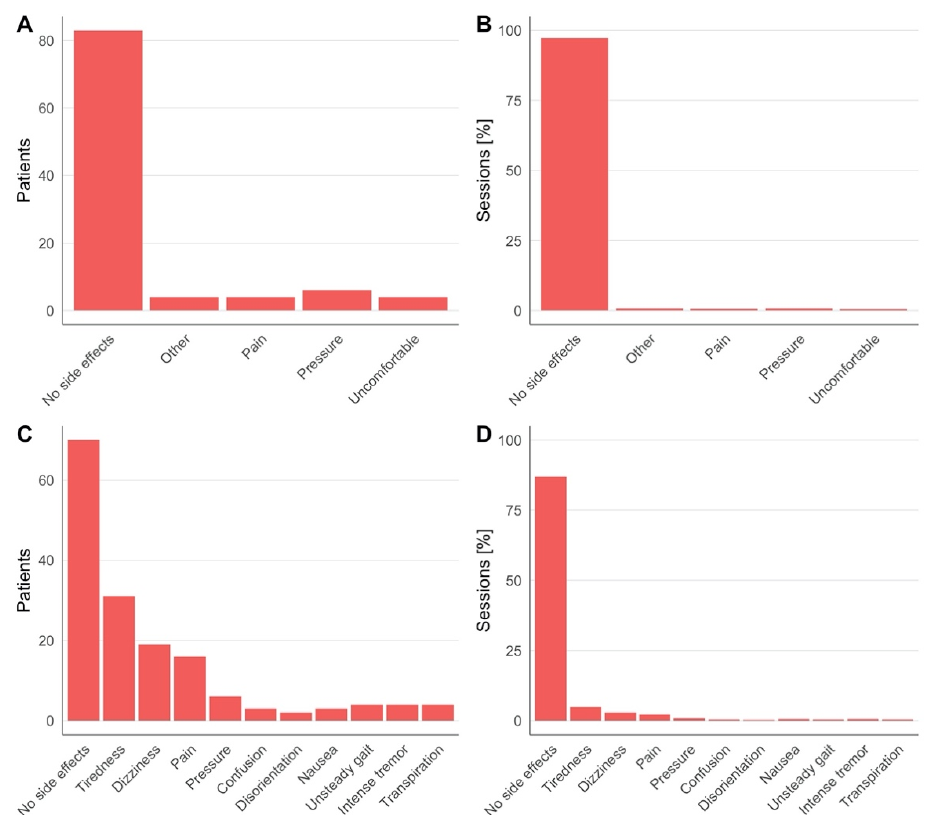
Figure 1. Experienced pressure and pain were rated during TPS treatment. ( A ) Percentages over all sessions and ( B ) number of patients across all sessions.